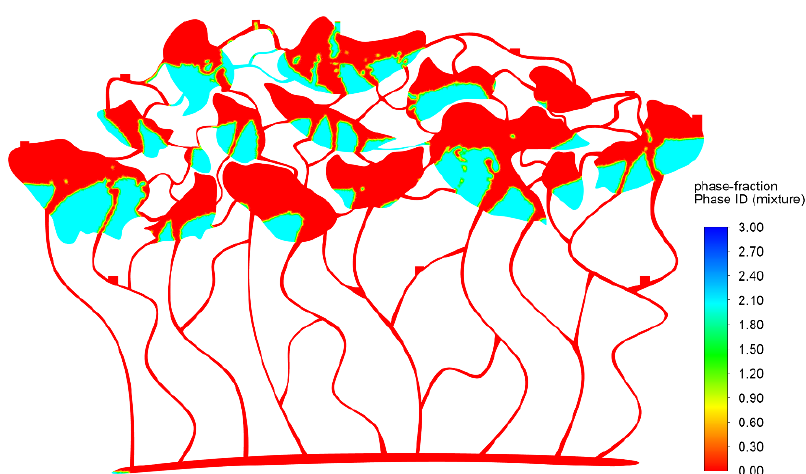
Figure 4. Original oil–water distribution (red—oil; light blue—water).